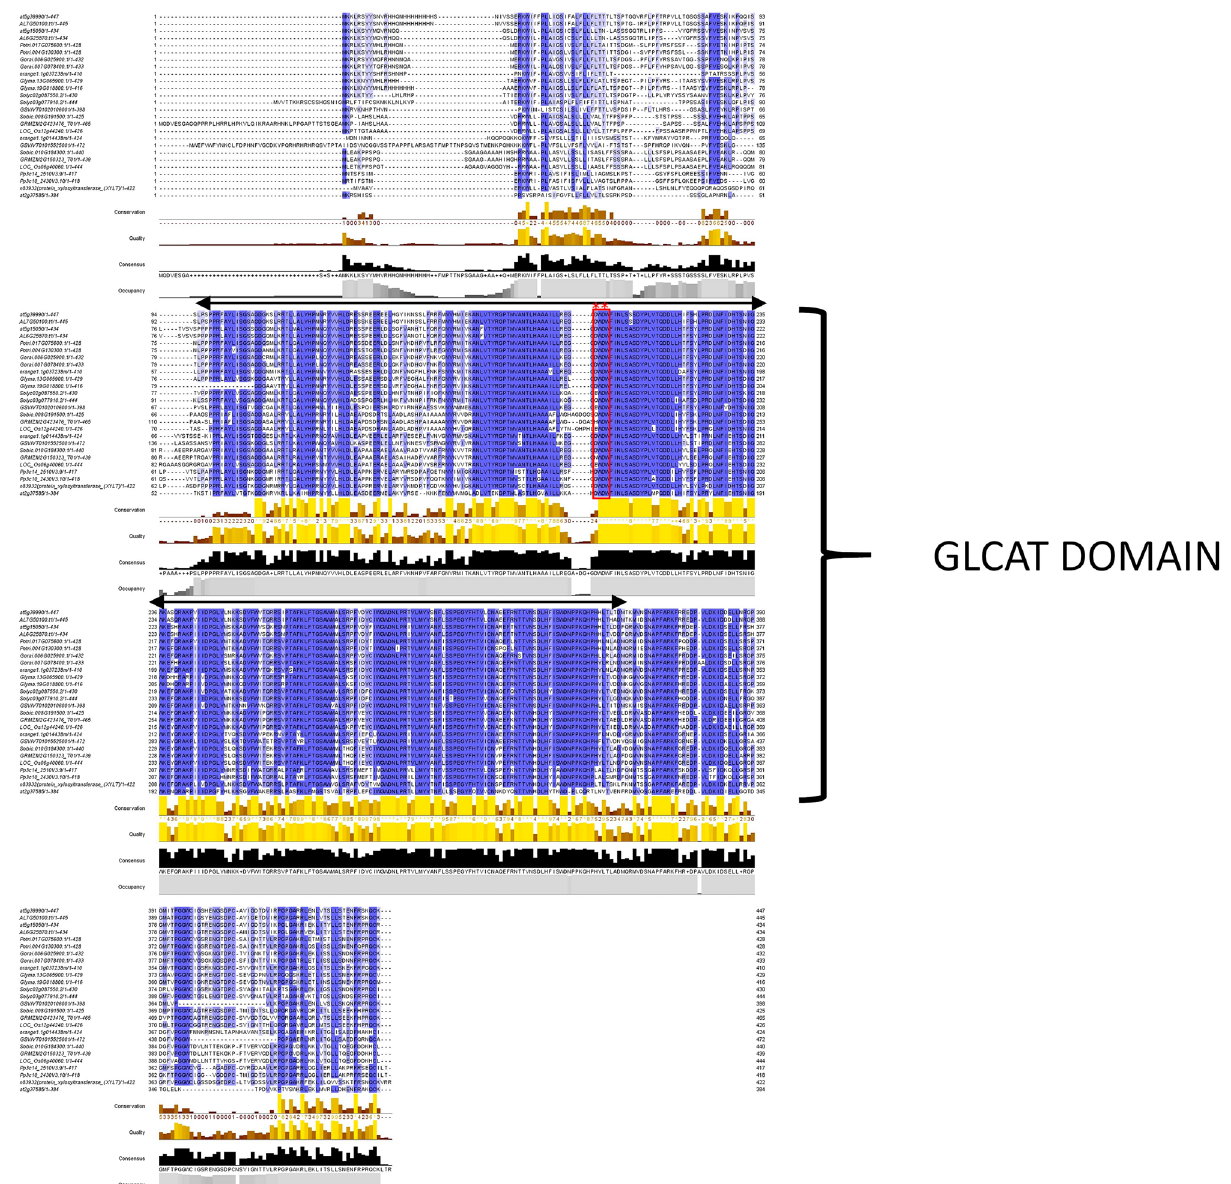
Figure 1. Protein alignment of representative GLCATs from various plant species. Twenty-six proteins representing the diversity of putative GLCATs in the investigated genomes were aligned using ClustalW and illustrated in Jalview 33 . Conserved GLCAT domains are indicated with black arrow lines. The X/DWD/X motif is indicated by the red box